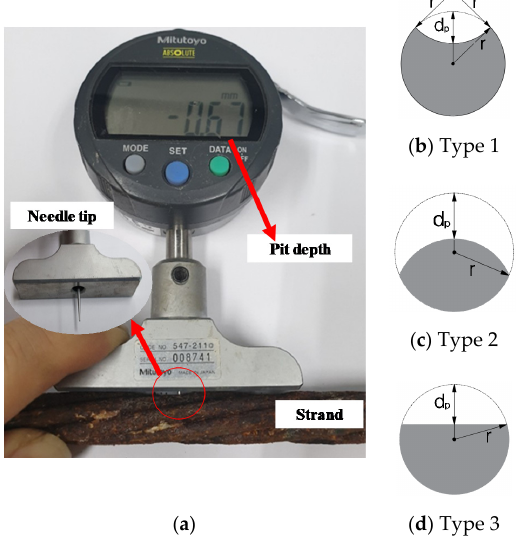
Figure 3. Section loss measurement using ( a ) pit depth gauge and ( b – d ) three idealized pit configurations [16,18].